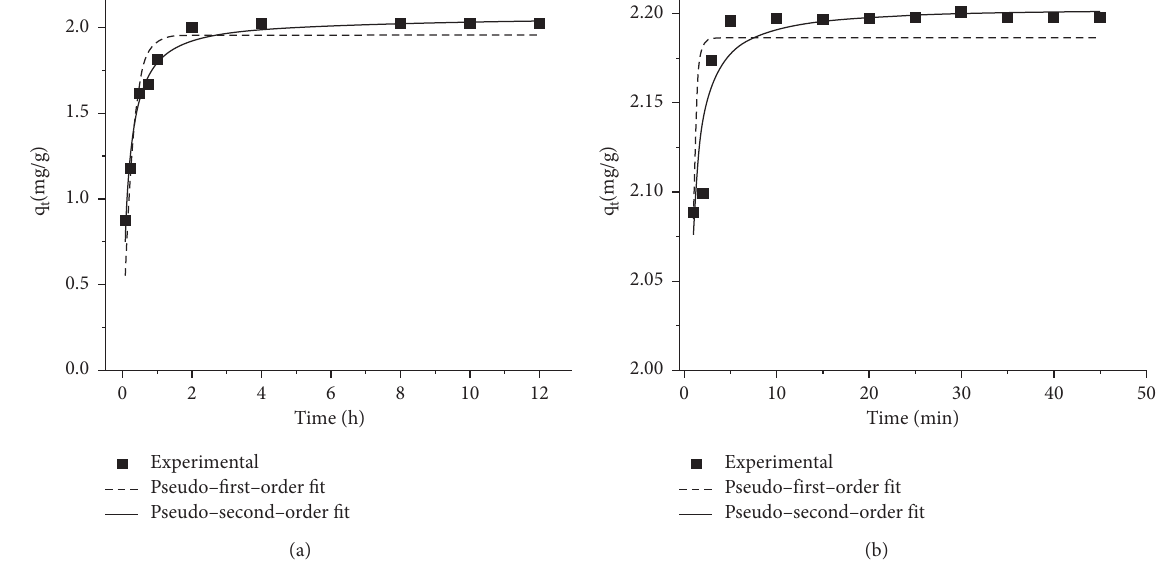
Figure 6: PSO and PFO plot for adsorption of Cr(VI) onto (a) TR and (b) Table 2: Parameters of the PFO and PSO kinetic models for Cr(VI) adsorption by TR and PSS.